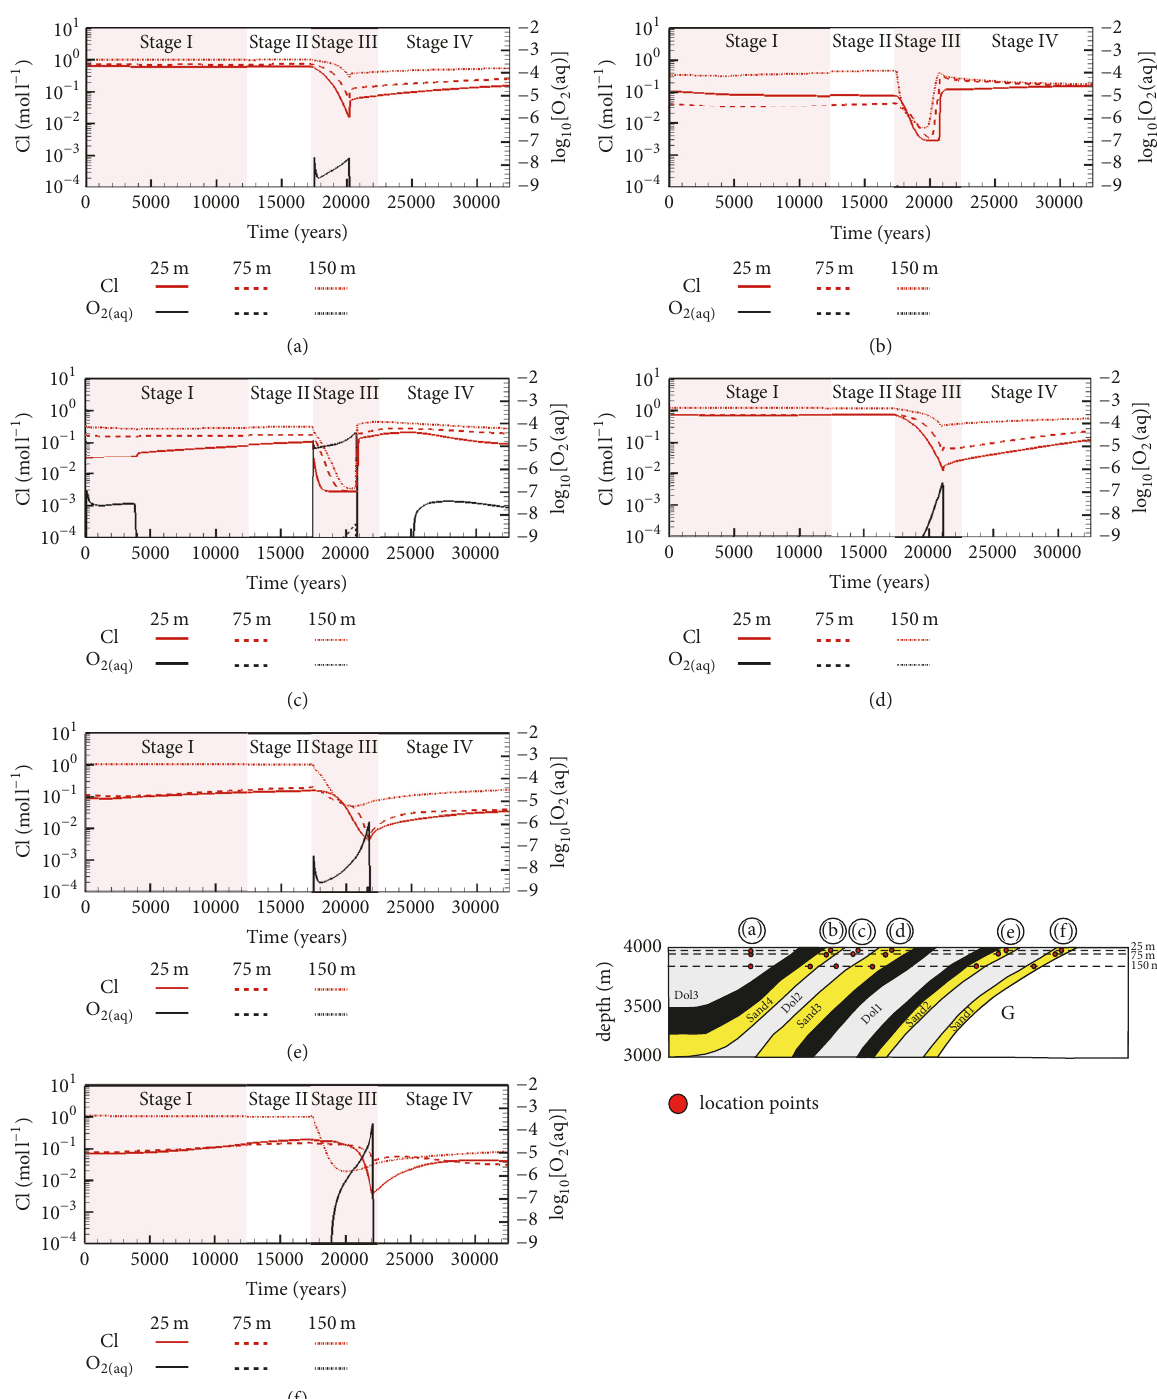
Figure 9: Temporal evolution of dissolved O 2 and Cl concentrations at the different observation point locations for Scenario 1 with a 10-fold increase of O 2 -consumption rates. (a), (b), (c), (d), (e), and (f) for Dol3, Sand4, Dol2, Sand3, Sand2, and Sand1, respectively. O 2 concentrations in mol l −1 . If O 2 profiles are not visible for a specific depth and unit, concentrations remain below 1 × 10 −9 moll −1 for duration of simulation.